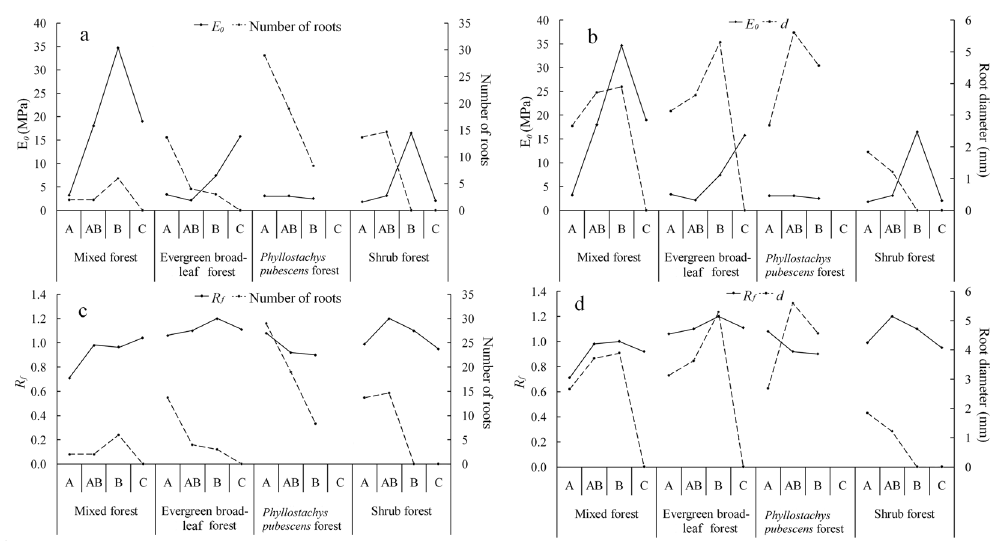
Figure 3. Correlations between root spatial characteristics (mean diameter and number of roots) and soil elastic-plastic properties ( R f and E 0